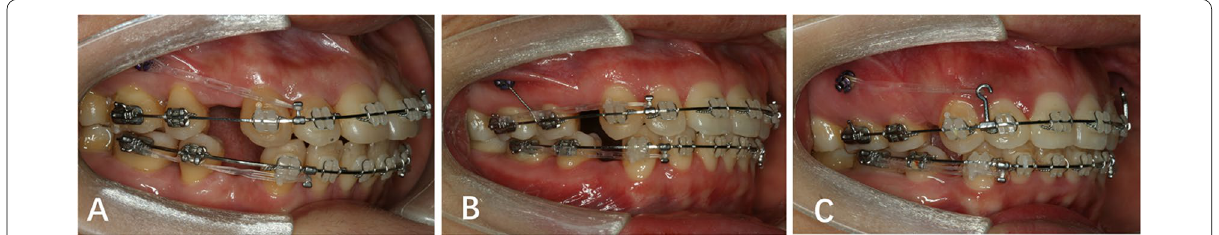
Fig. 1 Illustration of three miniscrew anchorage systems: A Direct miniscrew anchorages with low crimpable hooks (DL group); B indirect miniscrew anchorages with low crimpable hooks (IL group); C direct miniscrew anchorages with high crimpable hooks (DH